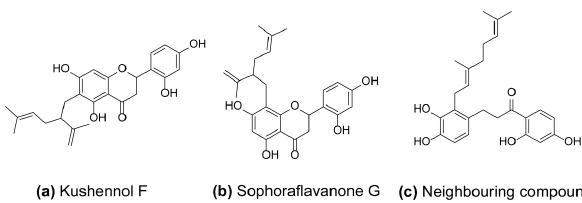
Figure 1. The chemial structures of ( a ) Kushennol F; ( b ) Sophoraflavanone G; and ( c ) Neighbouring compound acquired by prediction.